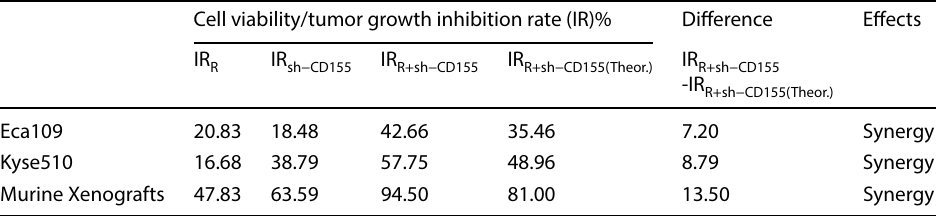
Table 2 Effects of irradiation and CD155 knockdown combination on cell viability and xenografts